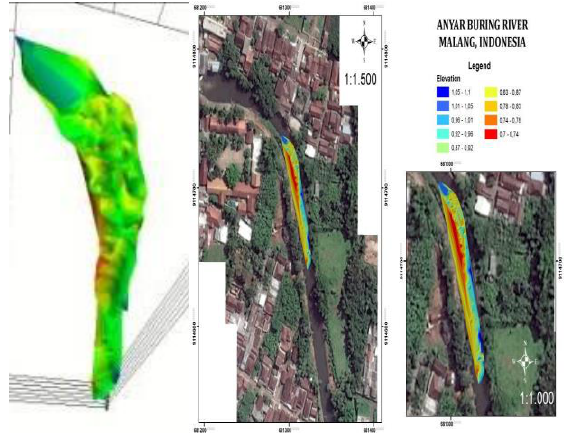
Figure 16. Example of normal bathymetry map/interpolation for continues riverbed model.